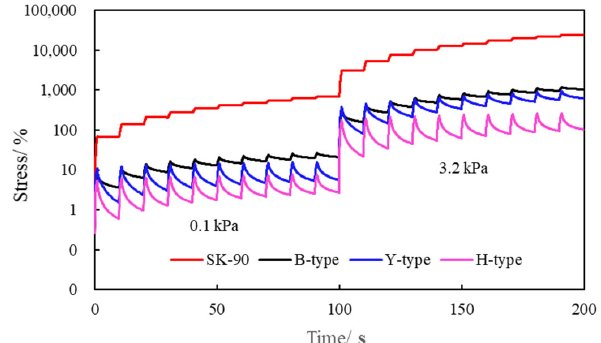
Figure 2. The time–strain relationship of different asphalt’s MSCR test.